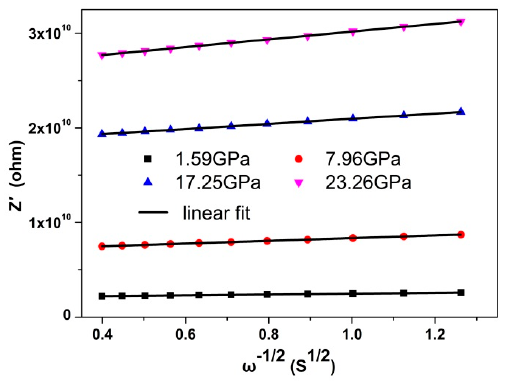
Figure 5. The Z ′ ~ ω − 1/2 curves at low frequencies under several pressures.